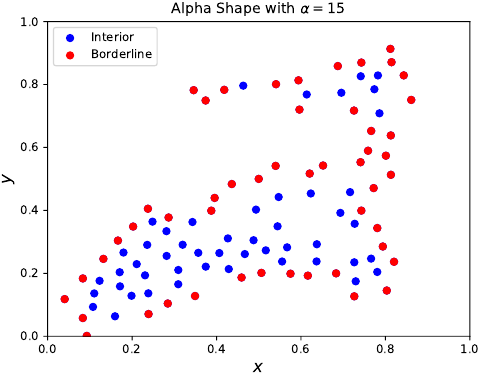
Figure 2. Example of alpha shape algorithm with α = 15 and 100